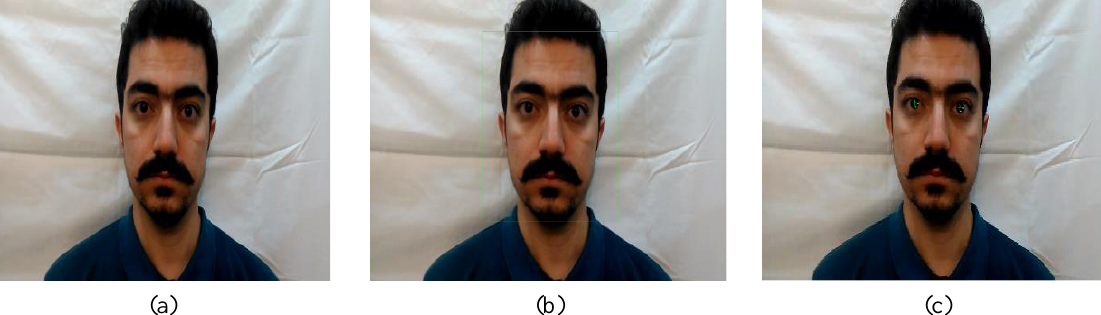
Figure 3. The process of personal algorithm of eye tracking: (a) Man image; (b) Recognition range of face; (c)The results of eye detection